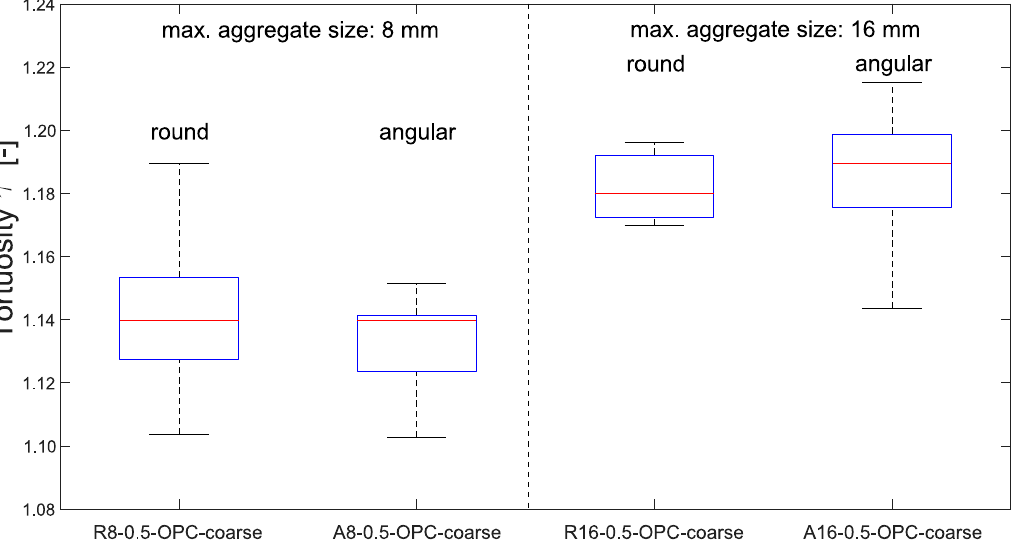
Figure 10. Effect of the aggregate shape on tortuosity (bottom and top edge of a box indicate the 25th and 75th percentiles, the band inside a box is the median, whiskers extend to the minimum and maximum data point within the 1.5 times interquartile range).